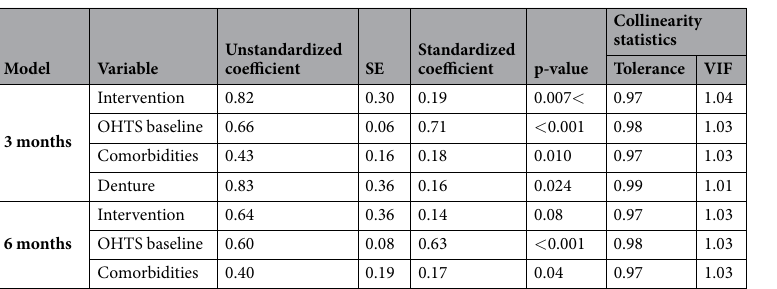
Table 3. Factors associated with OHTS (linear regression). 3-month model: adjusted R square = 0.64. 6-month model: adjusted R square =